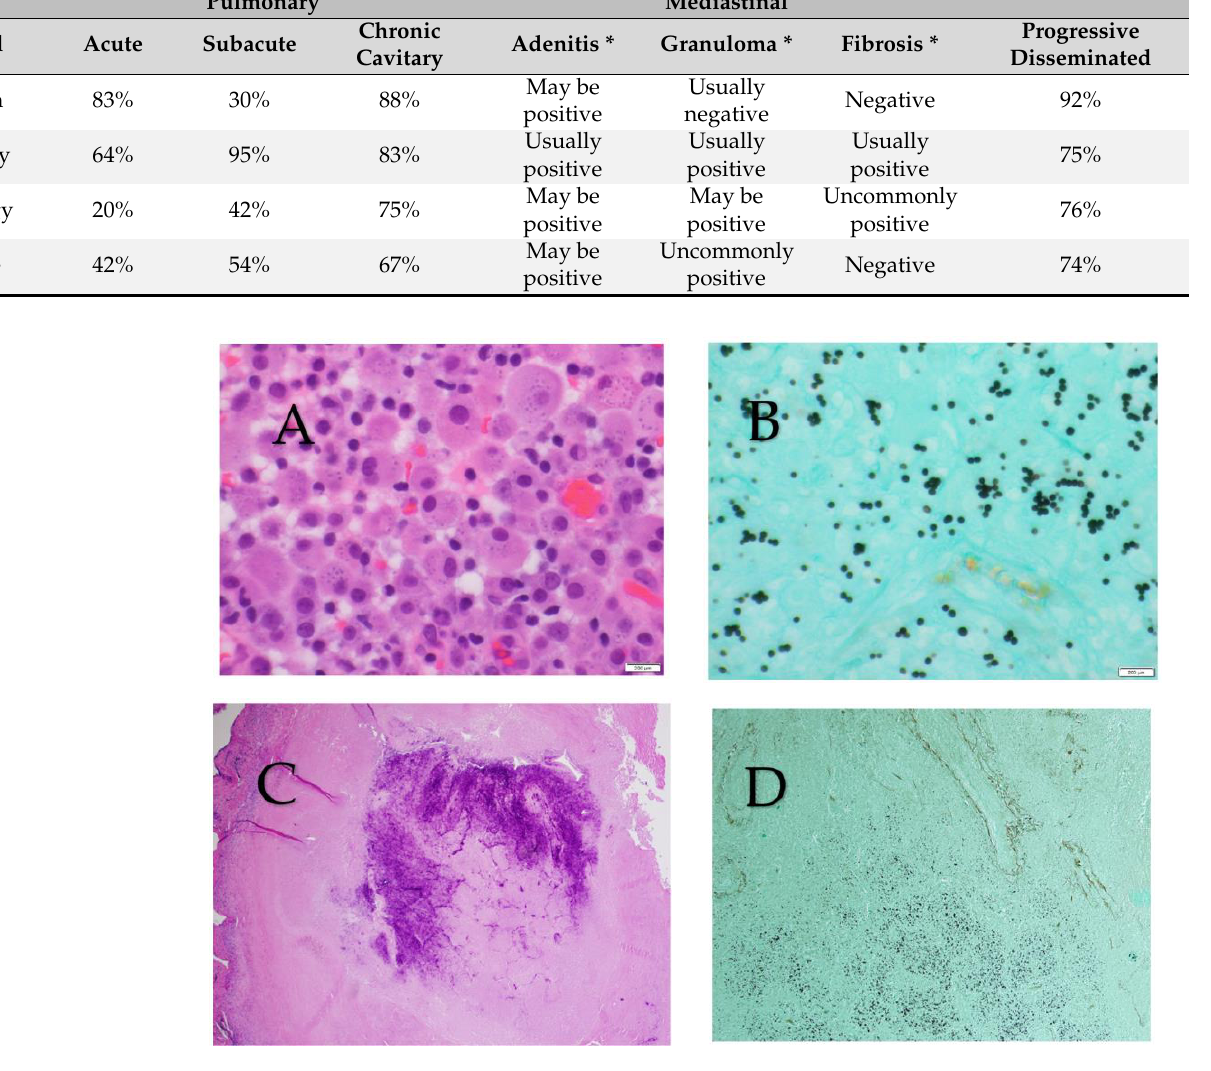
Figure 3. ( A ) Giemsa stain showing intracellular small ovoid yeast. ( B ) Grocott-Gomori’s methenamine silver showing small ovoid, narrow-based budding yeasts. ( C ) Hematoxylin-eosin stain of a caseating pulmonary granuloma. ( D ) Grocott-Gomori’s methenamine silver showing small yeast in a pulmonary granuloma.